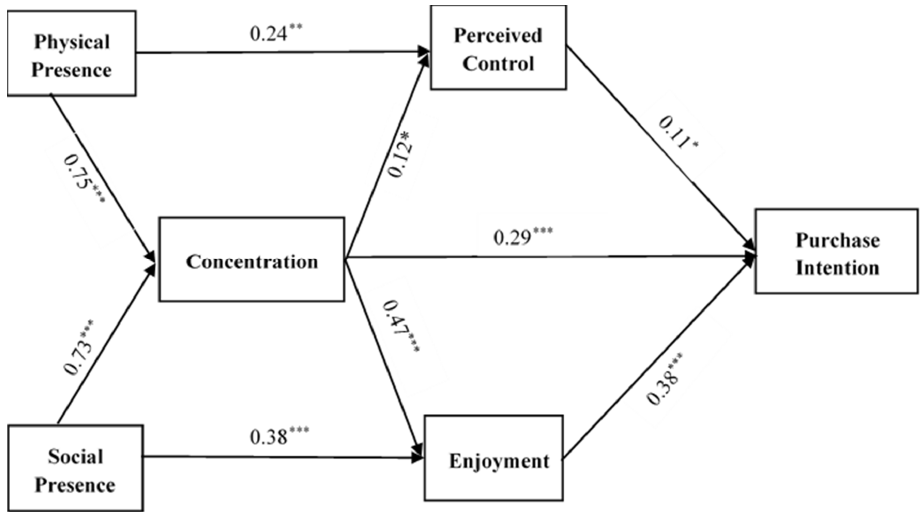
Figure 2. Regression results on presence and purchase intention in livestream shopping. * p <